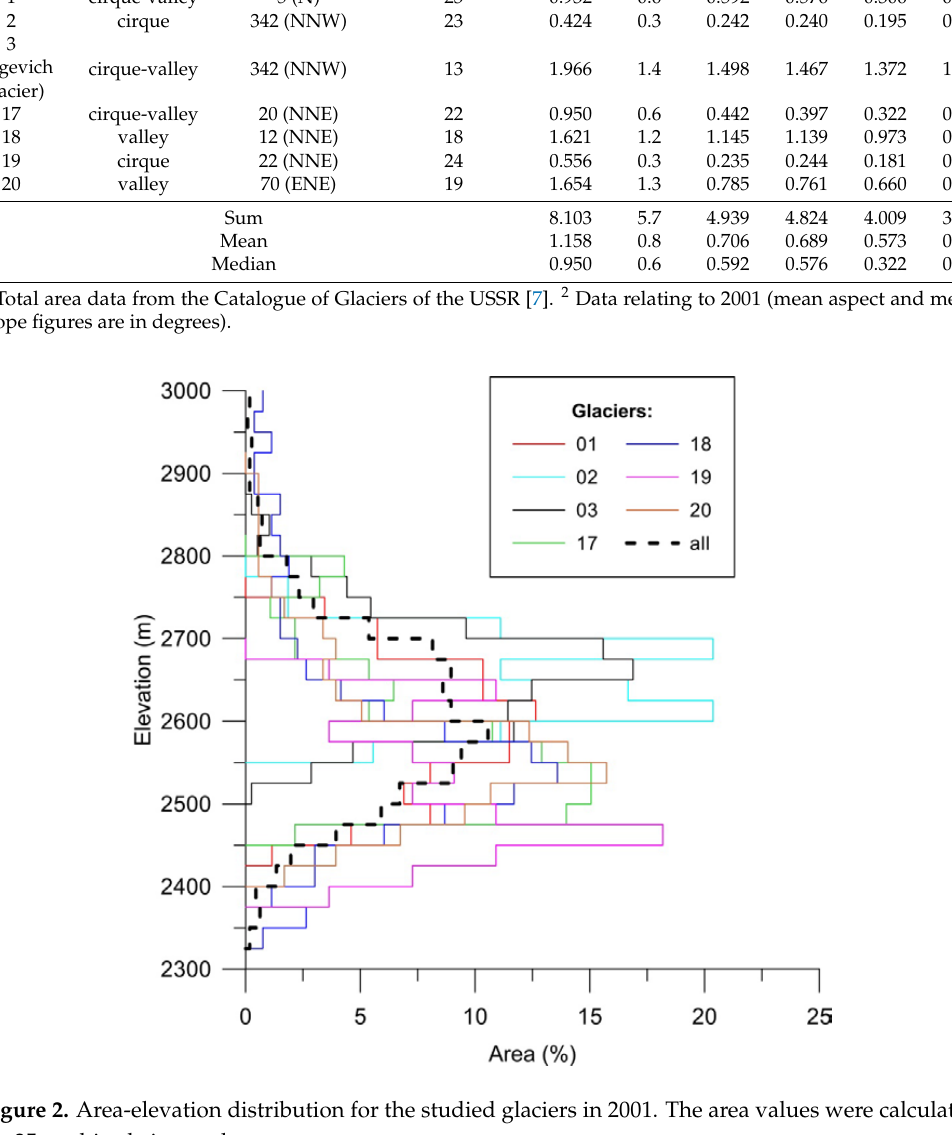
Table 2. Morphology and areas of the study glaciers from 1850 to 2010 (area values are in square kilometres). Adopted accuracy for individual ice area measurements from Landsat based data (1986–2010) is ± 10% (see in text).